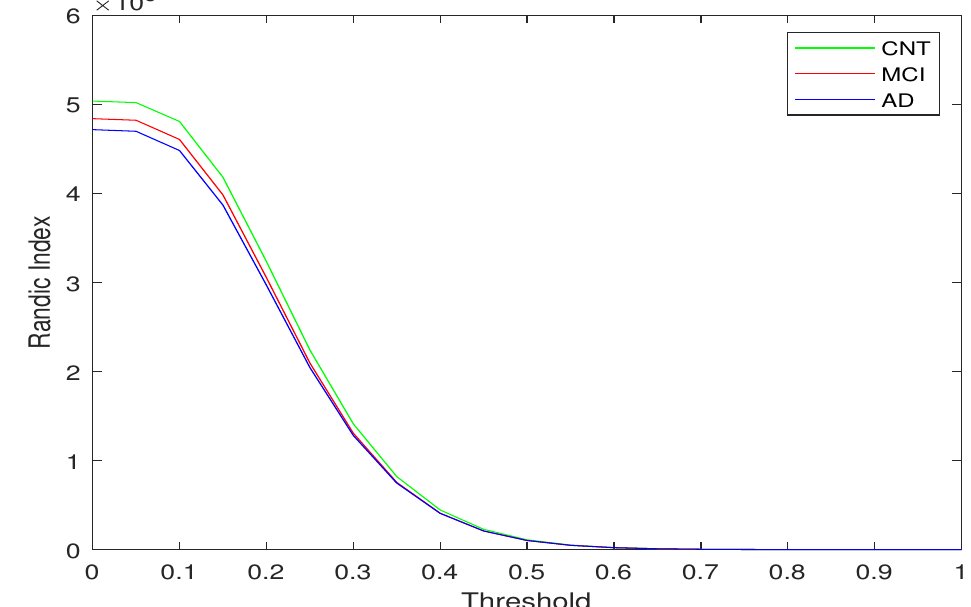
Figure 5. Mean values of the Randi´c Index ( R ( G ) ) computed by thresholding the connection matrices of CNT, MCI, and AD.